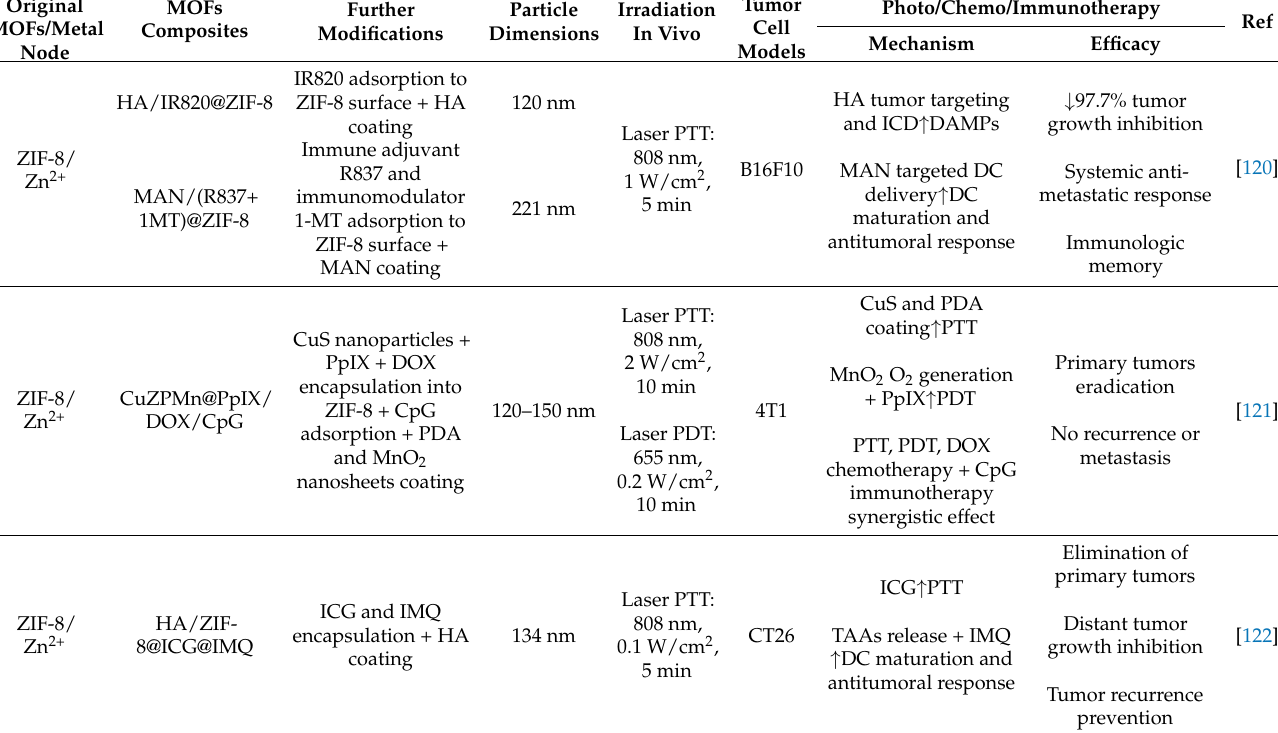
Table 1. MOF-based strategies for synergistic cancer photo-immunotherapy